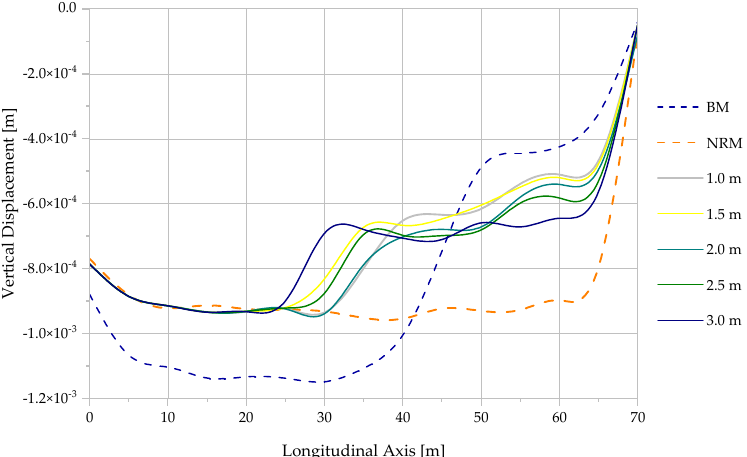
Figure 12. Vertical displacements when implementing the SHA90° with 19 and 15 BB sleepers per row in sets 1 and 2, respectively.